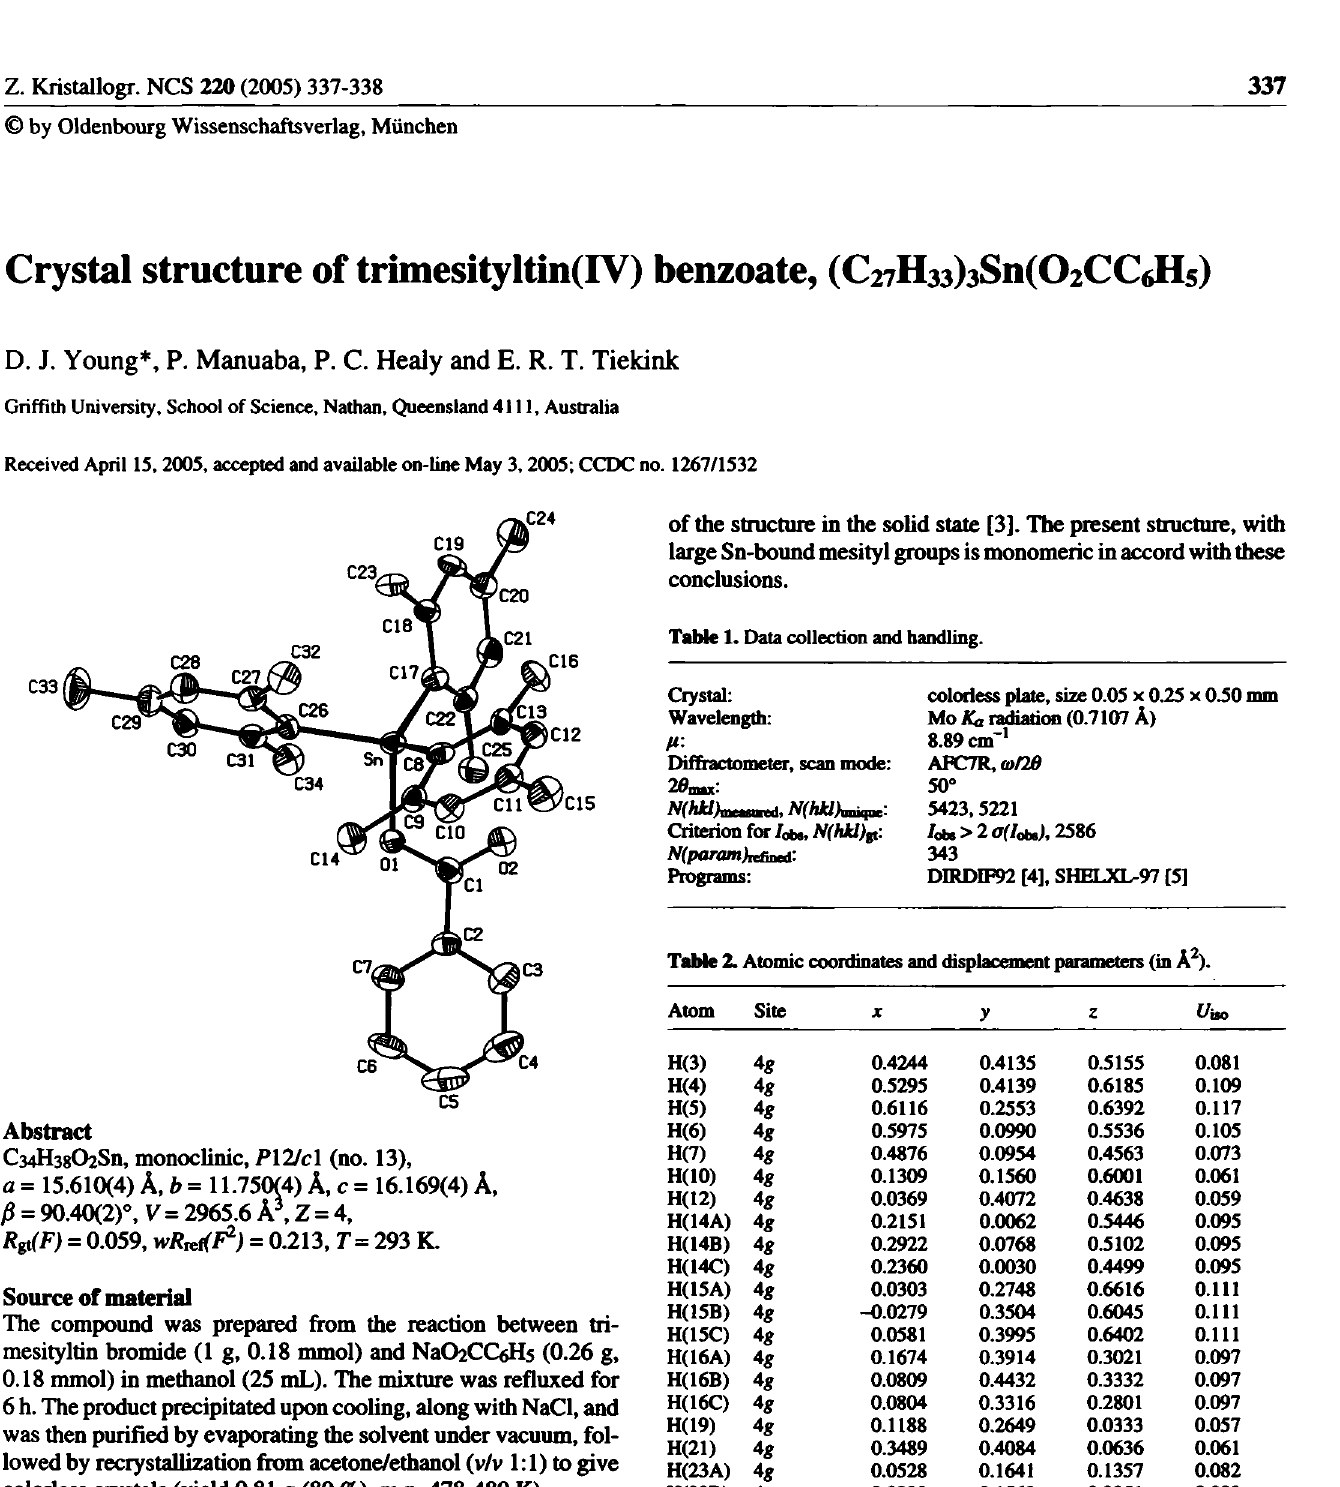
Table 2. Atomic coordinates and displacement parameters (in A 2